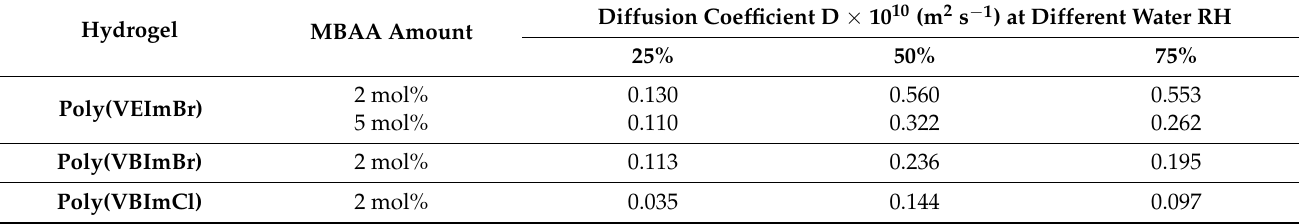
Table 5. Water diffusion coefficients in the hydrogels for different relative humidities at 30 ◦ C.